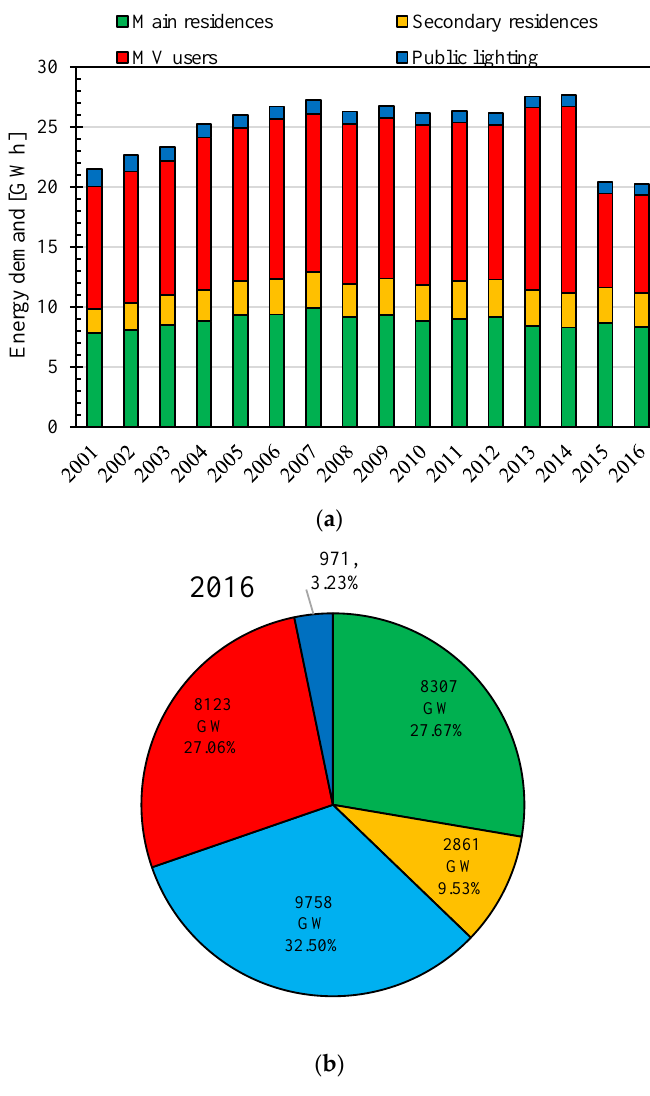
Figure A5. Electricity consumptions by users: ( a ) Yearly trend; ( b ) 2016 share [80]. Below, in Table A1, the reservoirs serving the desalination plants are detailed. Table A1. Characteristic of water reserves in Pantelleria network [90].